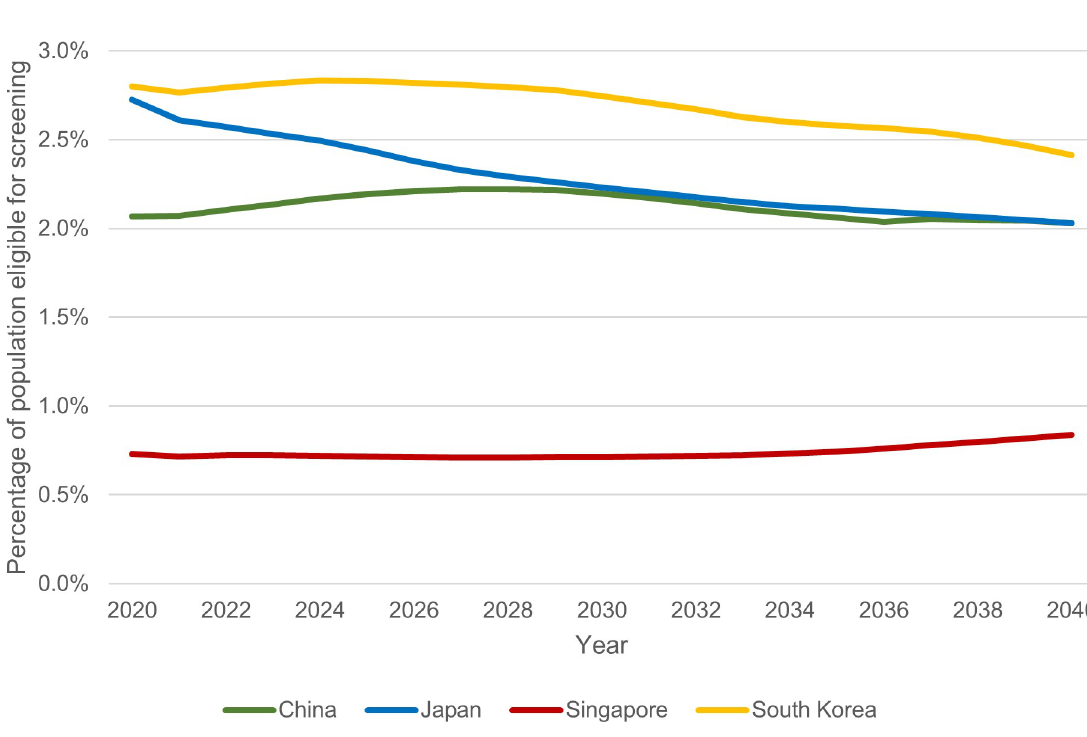
Fig 4. Percentage of population eligible for screening,